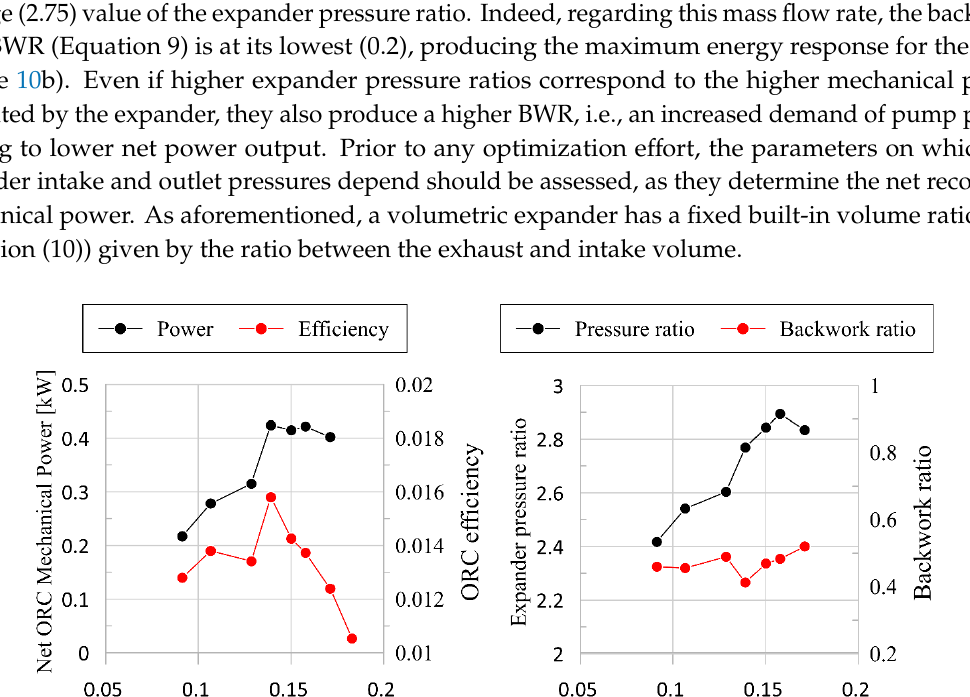
Figure 9. Comparison between experimental and predicted mechanical power at: ( a ) pump; and ( b ) expander.